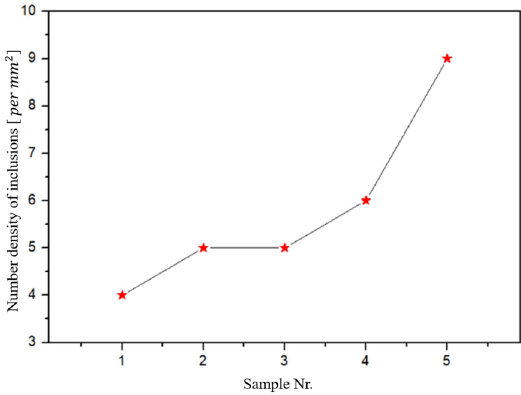
Figure 6. Number density of inclusions in ULC automotive